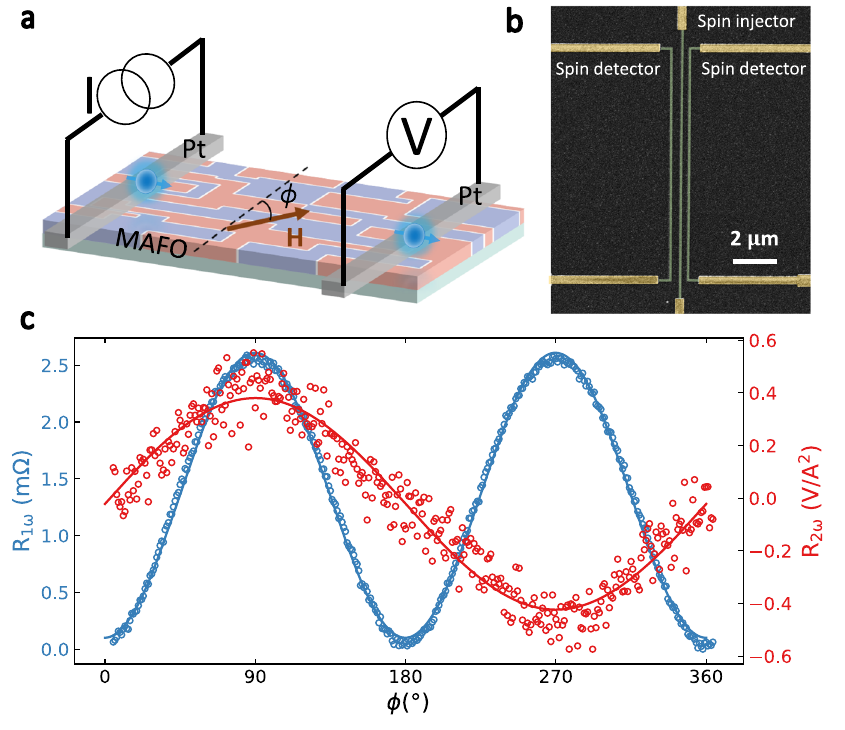
Fig. 2 | Nonlocal magnon transport measurement. a Schematic drawing of the experimental setup for nonlocal measurements. b False-color scanning electron microscope image of the device, in which green indicates the Pt wires and yellow